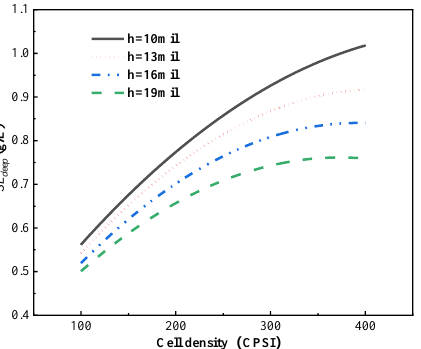
Fig. 12. Influence of the substrate cell density and wall thickness on the DPF carbon load in the deep- bed filtration phase under certain